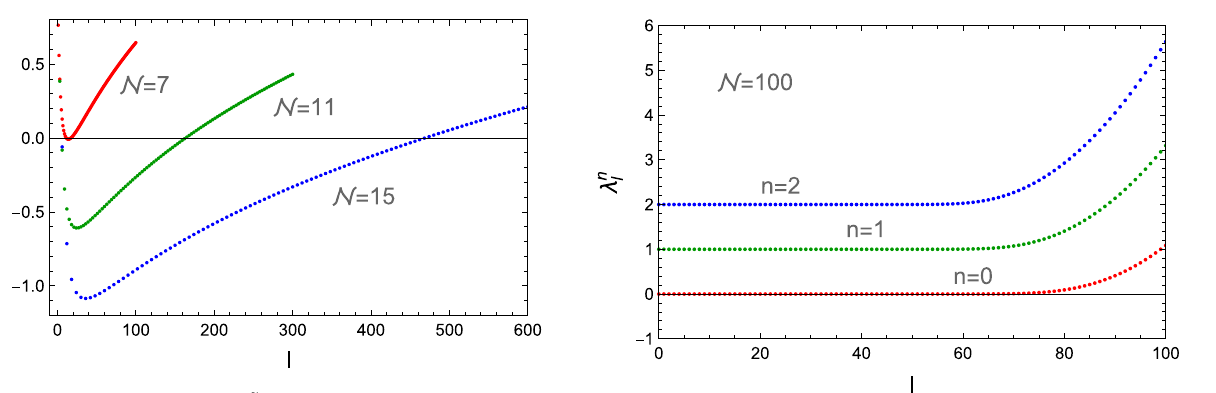
Fig. 1 The dimensionless energy ˜ E (cid:5) as a function of the orbital angu- 0 l lar momentum l for different values of N Fig. 2 The three lowest quasi Landau levels λ n tions of the orbital angular momentum l for N =